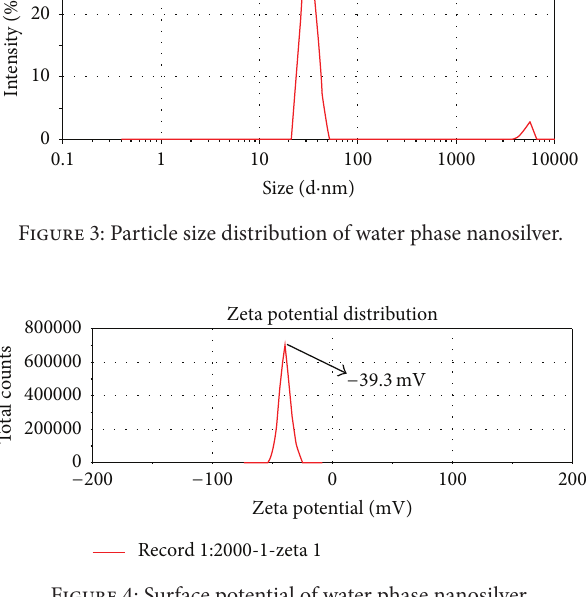
Figure 4: Surface potential of water phase